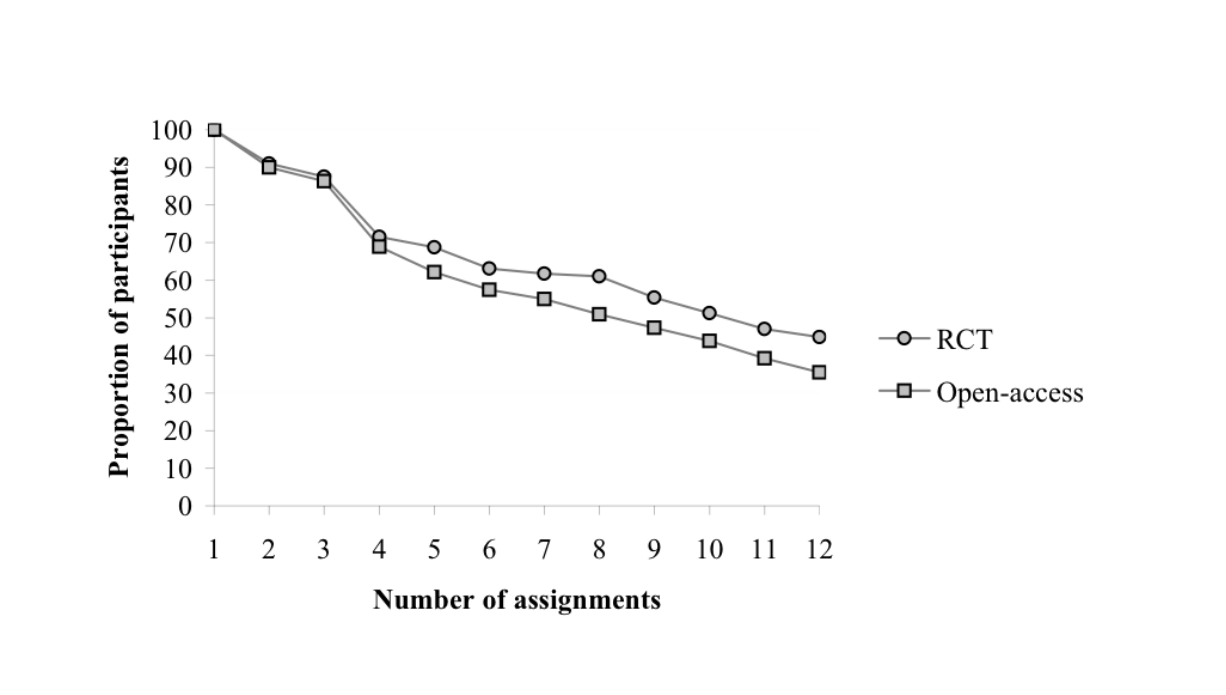
Figure 2. Attrition curve: proportion of participants by number of assignments in the randomized controlled trial (RCT) and open-access